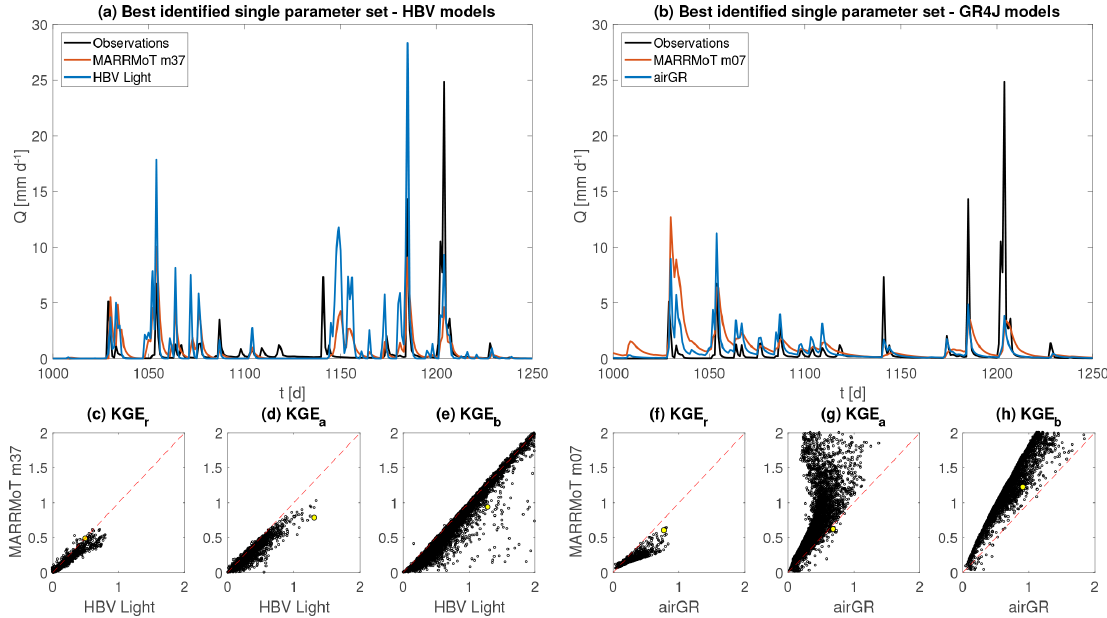
Figure 4. Comparison of two MARRMoT models and freely available model codes based on the same source material. (a) Close-up of hydrographs generated by MARRMoT m37 and HBV Light using the same parameter values for their shared parameters. (b) Close-up of hydrographs generated by MARRMoT m07 and airGR-GR4J using the same parameter values. (c) – (e) Constitutive components of the Kling–Gupta efficiency (KGE) obtained by HBV Light and MARRMoT m37 for 10000 parameter sets in a single catchment. The yellow dot indicates the parameter set used to generate (a) . (f) – (h) Constitutive components of the KGE obtained by airGR-GR4J and MARRMoT m07 for 10000 parameter sets in a single catchment. The yellow dot indicates the parameter set used to generate (b)